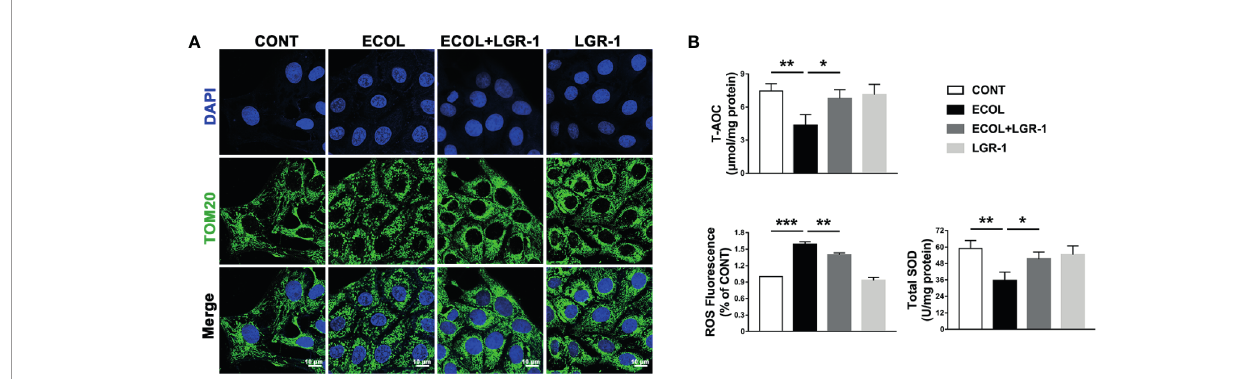
FIGURE 5 | LGR-1 alleviates Escherichia coli- induced ROS production, mitochondrial damage in MAC-T cells. (A) Representative immuno fl uorescence images of TOM20 (Green). DAPI (Blue, nucleus). Scale bar, 10 µm. (B) T-AOC and SOD and ROS levels. Con fl uent MAC-T cell were pretreated with LGR-1 (10 5 CFU/mL, MOI = 1) for 3 h, washed three times with PBS, and exposed to E coli (10 7 CFU/mL, MOI = 66). Cells were analyzed 8 h after E coli infection. Data presented are mean ± SEM; n = 3. * p < 0.05, ** p < 0.01, *** p < 0.001.